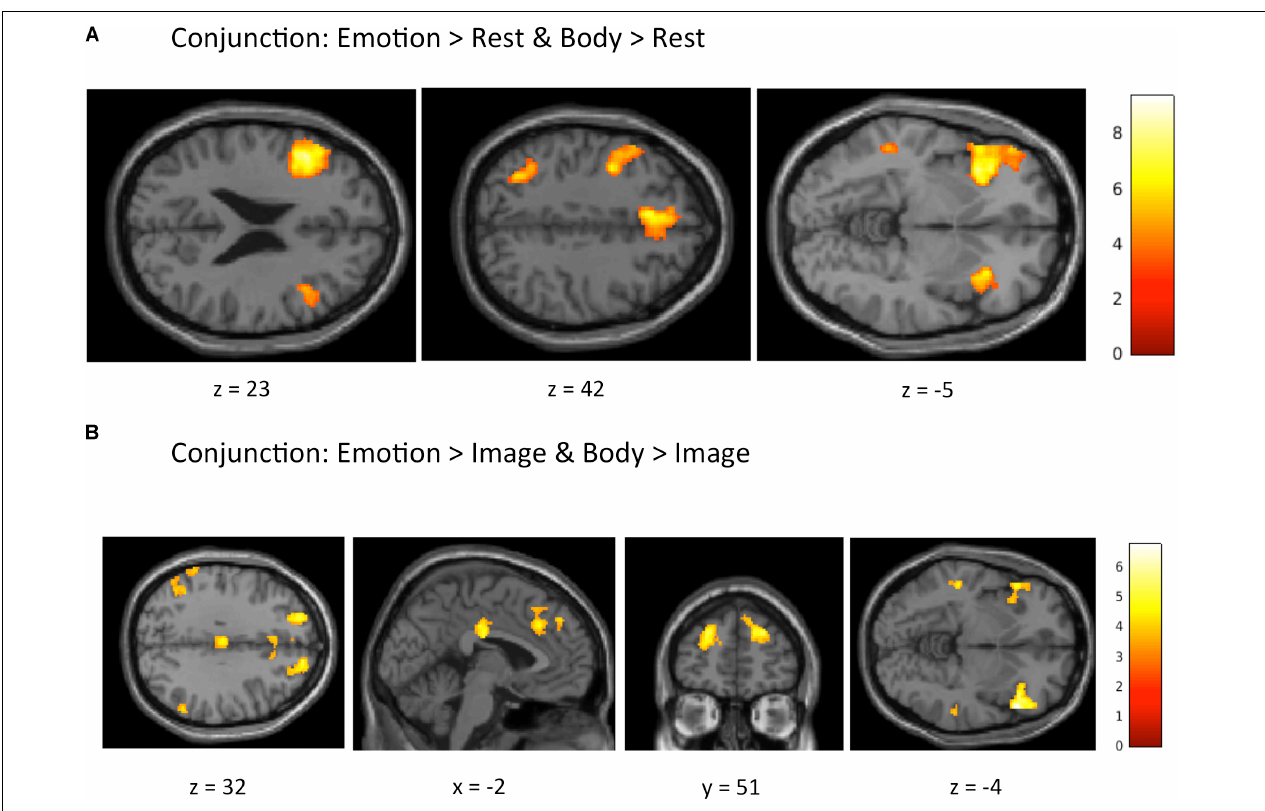
FIGURE 4 | Illustration of the imaging results for conjunction analyses showing common activations within (A) the “Emotion > Rest” and “Body > Rest” contrasts, and (B) the “Emotion > Image” and “Body > Image” contrasts reported in Table 4 . As in the tables, the clusters displayed here are thresholded based on a cluster-forming height threshold of p < 0.001 (uncorrected), and a subsequent cluster extent threshold of p < 0.05 (FDR-corrected). Images are shown in neurological orientation (i.e., left = left; right =